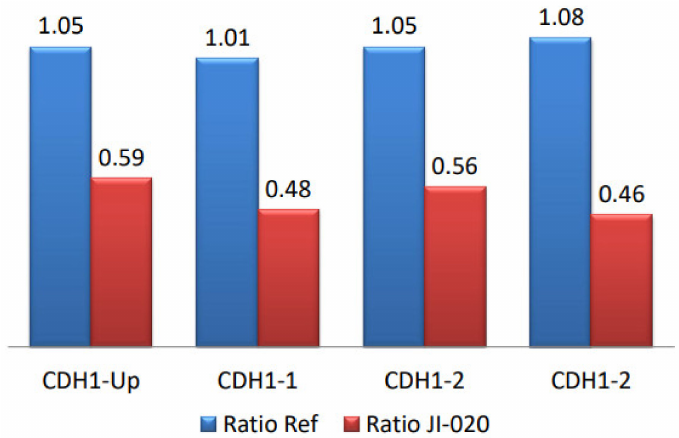
Figure 4. Detection of CDH1 exon deletions by MLPA assay. (Blue) Control probes, (Red) Index cases harboring exon deletions ( CDH1 Exons 1 and 2).